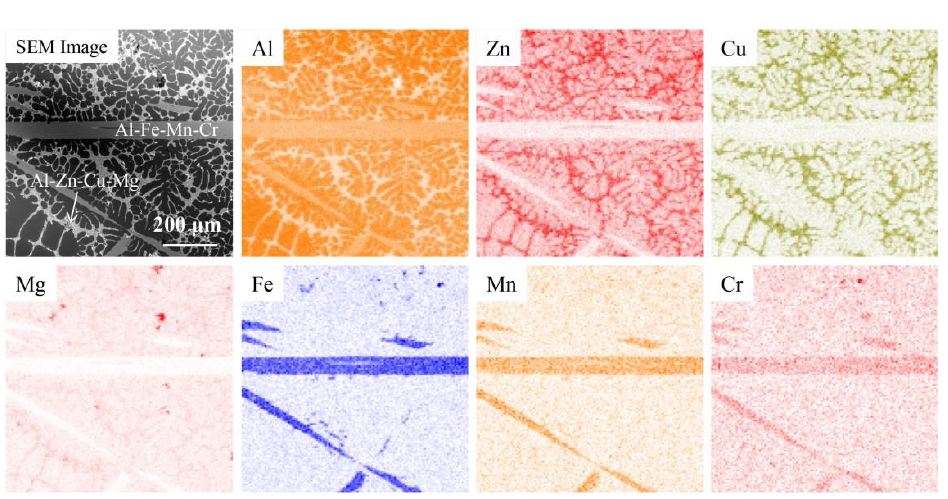
Figure 6. EDS mapping results of layer 1 in trial 4.